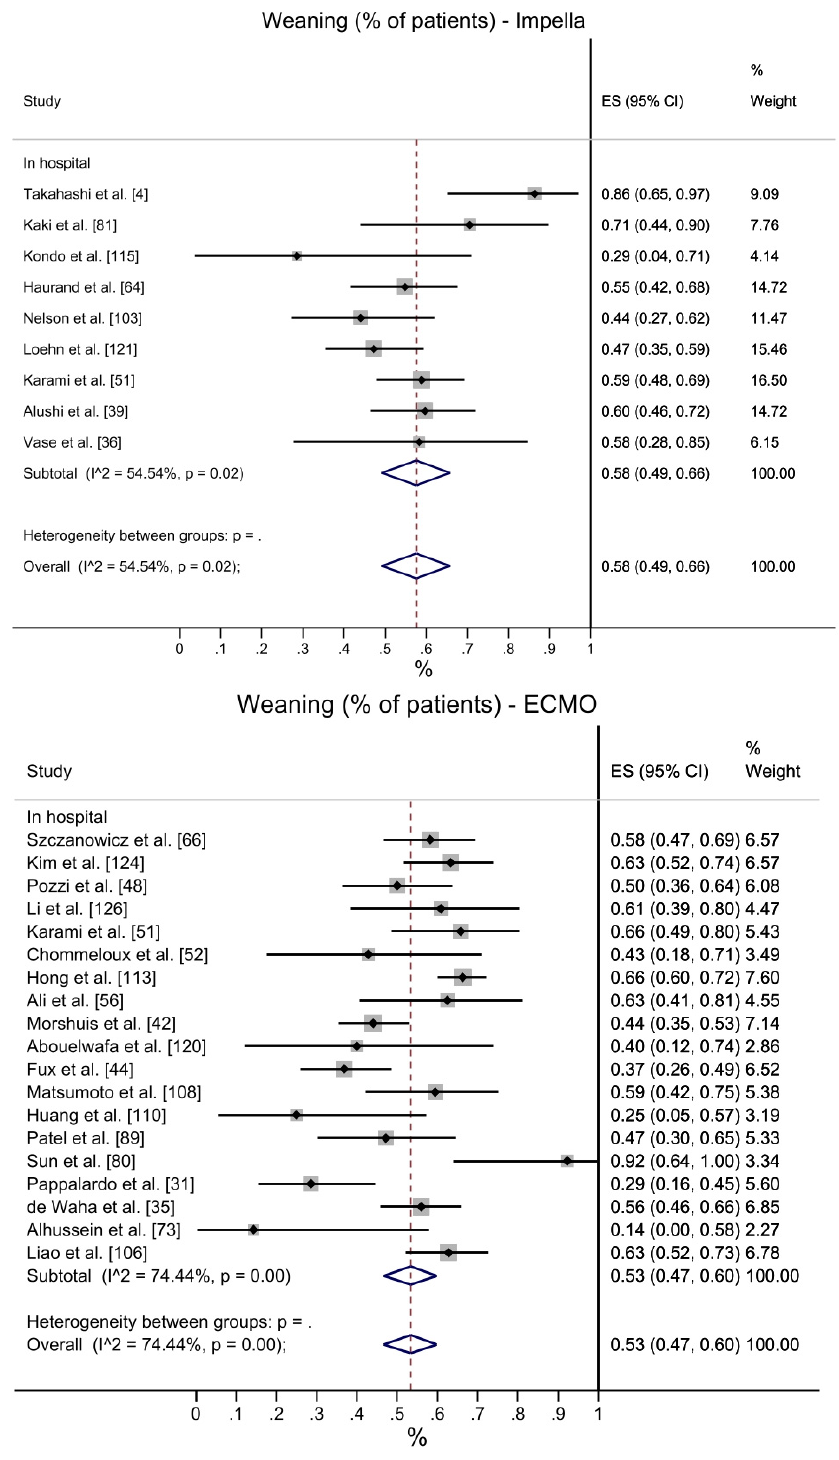
Figure 3. Weaning: Impella vs. VA-ECMO. [4,31,35,36,39,42,44,48,51,52,56,64,66,73,80,81,89,103,106,108,110,113,115,120,121,124,126]